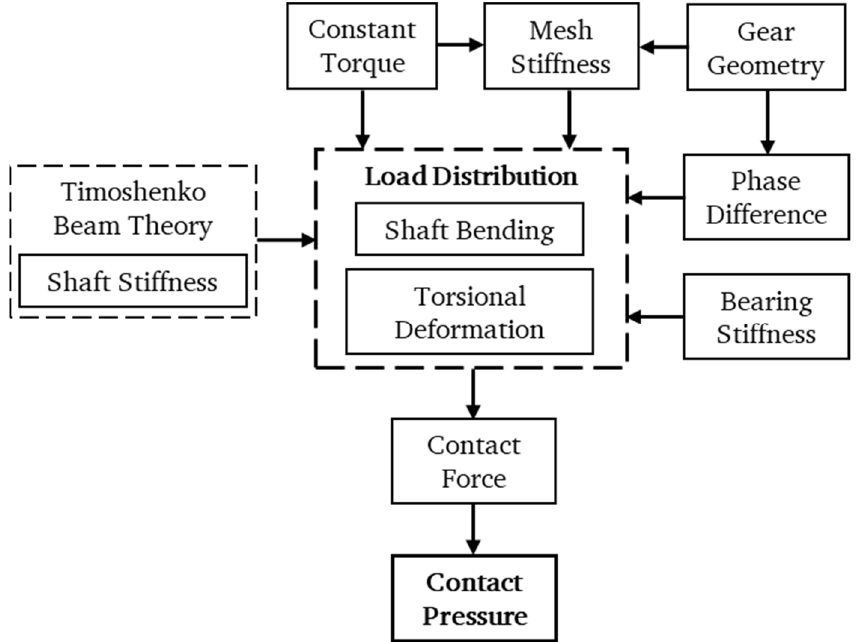
Figure 7. Flow chart used for the pressure distribution of the torque split model.